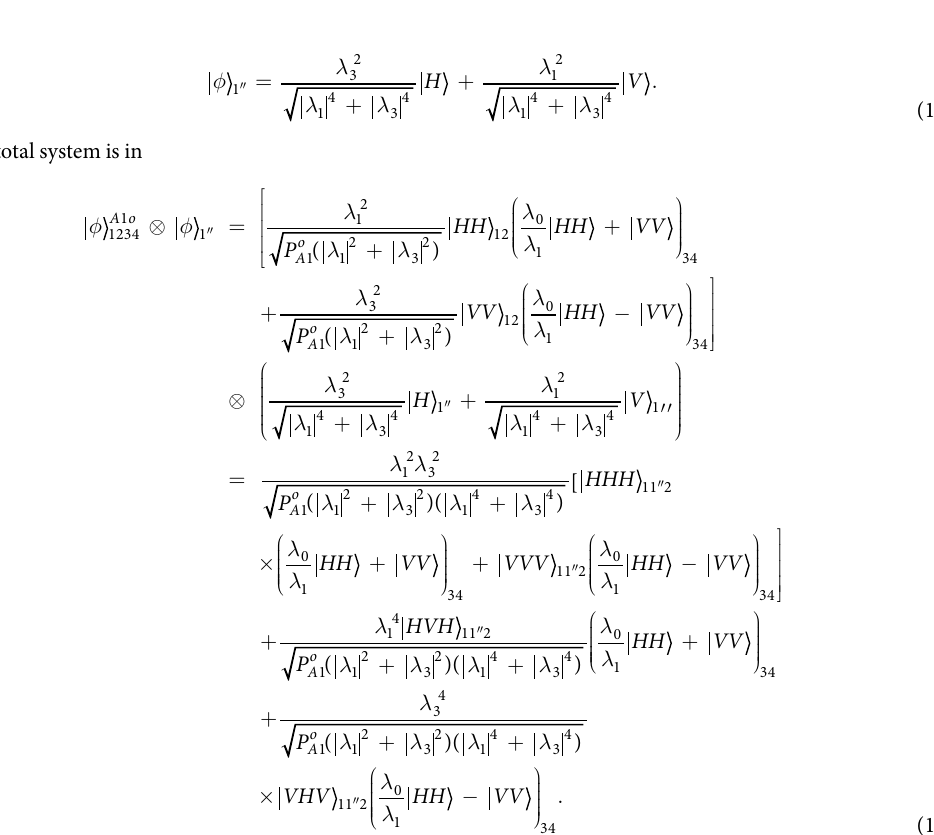
Figure 3. Schematic drawing of PCD operated on the original particle 1 and the ancillary particle 1 ′ 35 . ± θ represents that cross-Kerr nonlinearity makes | α 〉 into | α e ± i θ 〉 when there is a particle passing. The even-parity states | HH 〉 and | VV 〉 will introduce phase shift ± θ to | α 〉 , while the odd-parity states | HV 〉 and | VH 〉 result in no phase shift. | χ 〉〈 χ | is the homodyne measurement that can distinguish different phase